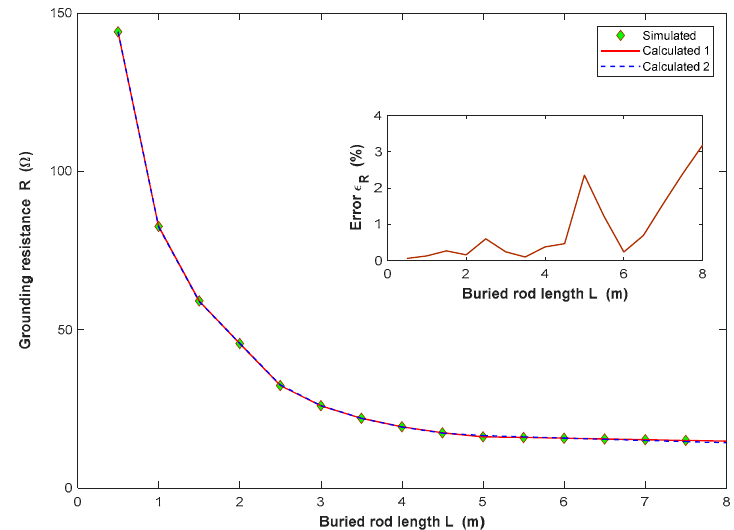
From data of Table 1, a MatLab-based minimization algorithm using the fminsearch routine is launched where the objective function is (17). The parameters of the model ob- tained from the minimization procedure are ρ 1 = 99.01 Ω m, ρ 2 = 49.79 Ω m, ρ 3 = 292.45 Ω m, h 1 = 2.03 m, and h 2 = 2.94 m. Figure 4 shows by using diamond markers the values on the Table 1. The red continuous line, labeled as Calculated 1, stands for the calculated ground- ing resistance from the obtained optimum solution while the dashed blue line, labeled as Calculated 2, shows the calculated grounding resistance from the true soil parameters. The subfigure in Figure 4 stands for the percentage error ε R = ( R true − R calc ) / R true in the calculation of the grounding resistance using the estimated soil model, where R true is the grounding resistance from the true soil model, whilst R calc is the calculated grounding resistance from the estimated soil model.